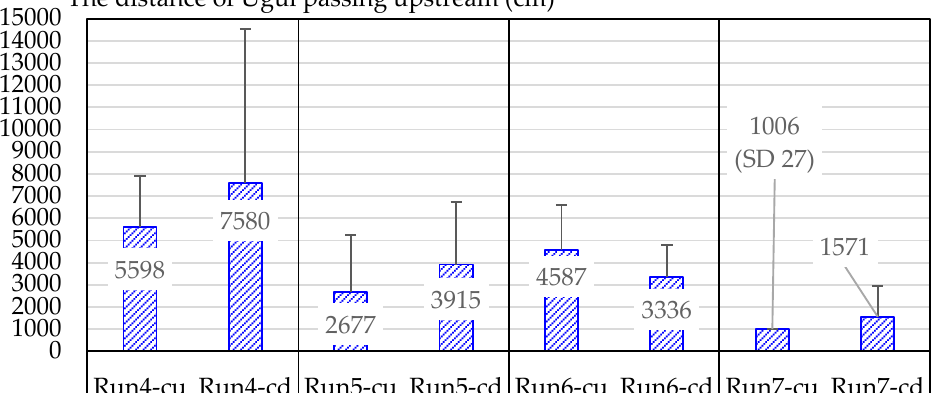
Figure 16. The average distance of Ugui passing upstream that successfully moved upstream in each case (Run4-cu and Run4-cd are previous study [4]).